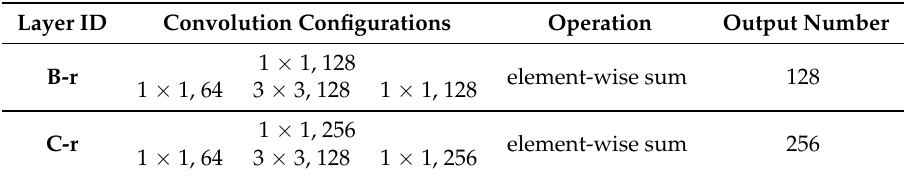
Table 3. Configurations of the residual